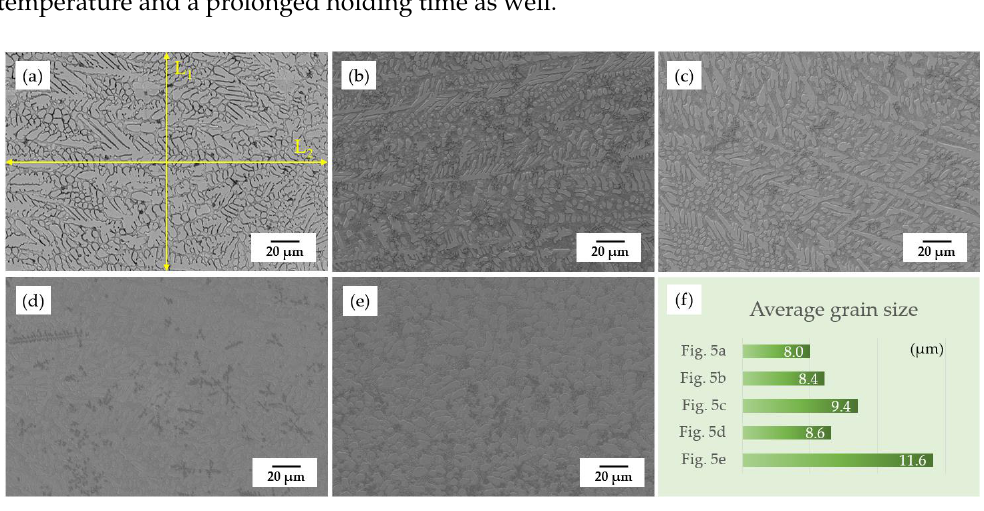
Table 4. Measuring results of average grain size with linear intercept method.